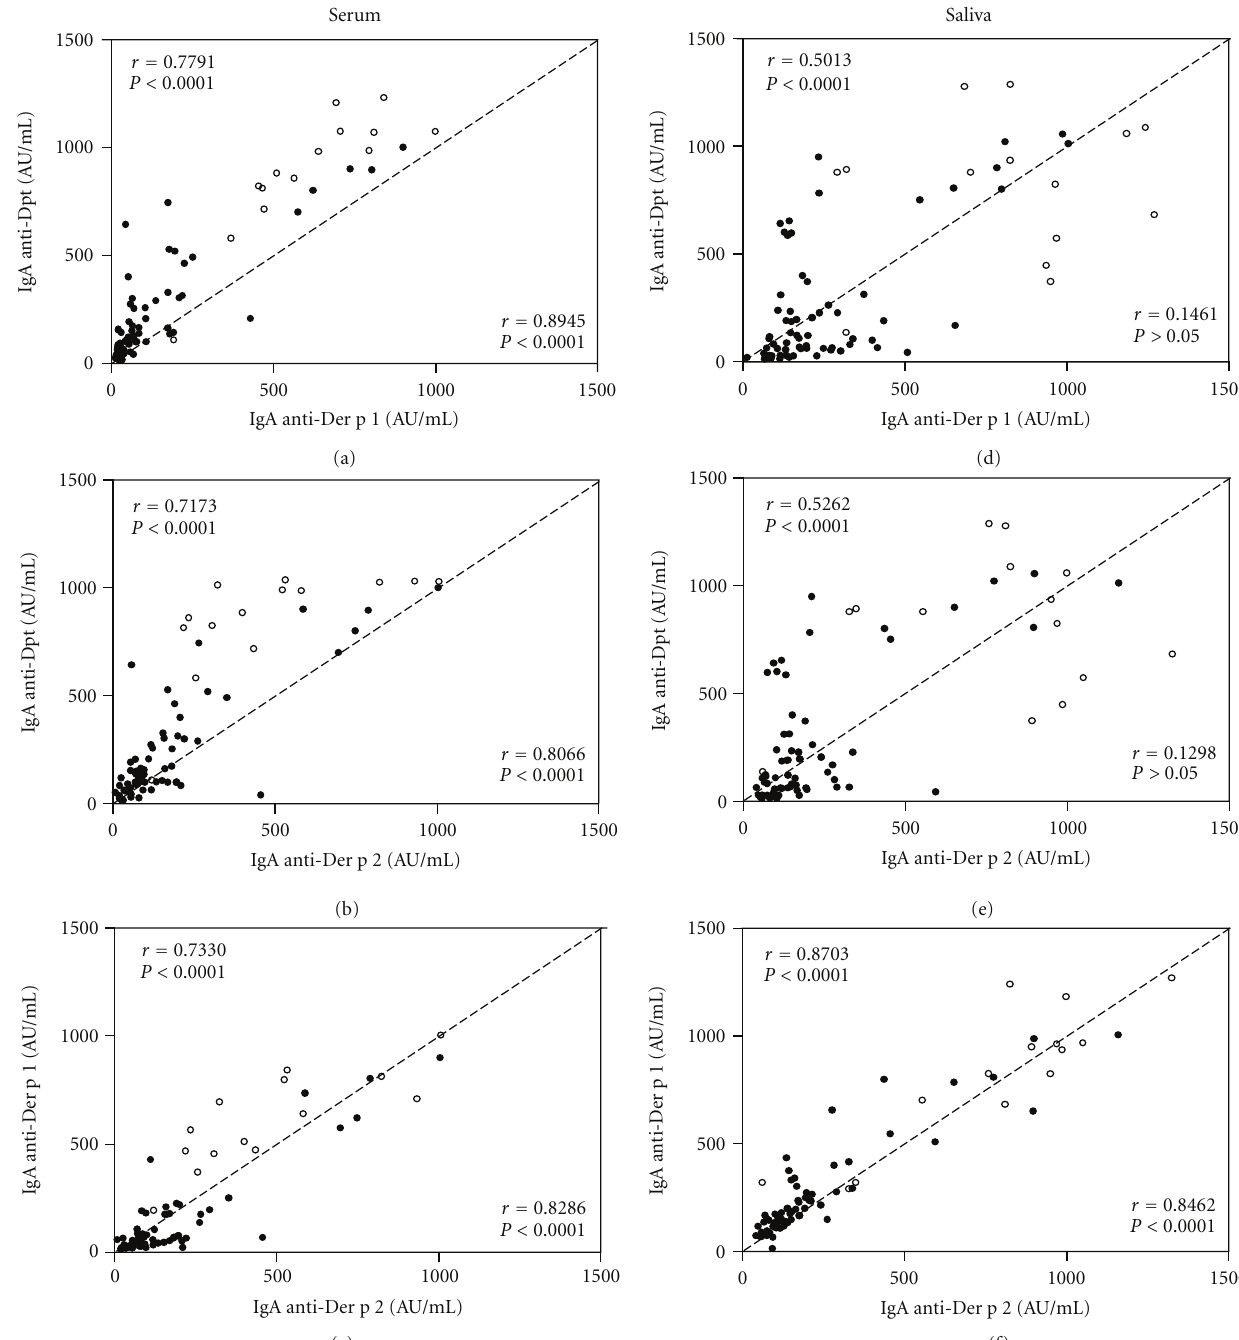
Figure 4: Correlation between levels of IgA antibodies to Dermatophagoides pteronyssinus (Dpt) crude extract and its major allergens (Der p1 and Der p2) in serum (a–c) and saliva (d–f) samples from 72 allergic ( • ) and 14 nonallergic ( ◦ ) children. Data are expressed in arbitrary units per milliliter (AU/mL) and the dashed line indicates a perfect correlation. The Spearman correlation coe ffi cients ( r ) and statistical significance are also indicated for allergic (on the upper left corner) and nonallergic (on the lower right corner) children.